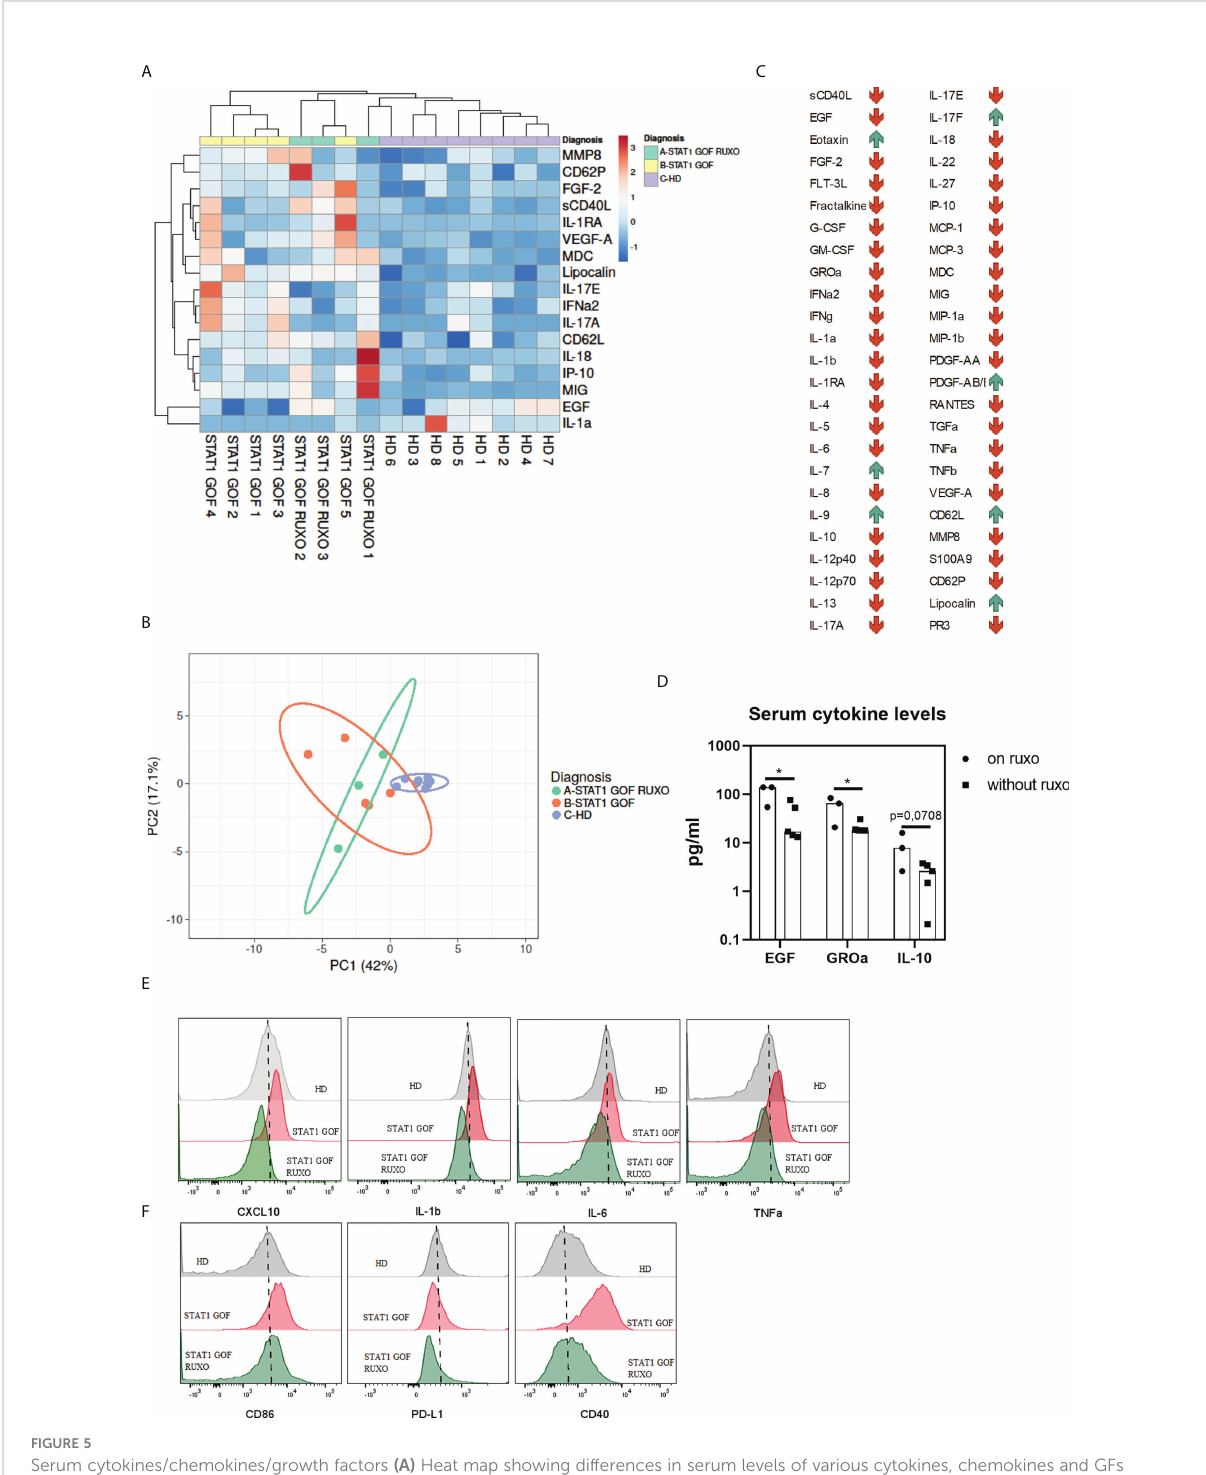
FIGURE 5 Serum cytokines/chemokines/growth factors (A) Heat map showing differences in serum levels of various cytokines, chemokines and GFs between STAT1 GOF patients (n = 5), ruxolitinib-treated STAT1 GOF patients (STAT1 GOF RUXO) (n = 3) and HDs (n = 7) detected by LUMINEX (B) Principal component analysis showing differences in serum levels of various cytokines, chemokines and GFs between STAT1 GOF patients (n=5), ruxolitinib-treated STAT1 GOF patients (STAT1 GOF RUXO) (n = 3) and HDs (n = 7) (C) Dynamics of analytes in a patient before and on ruxolitinib treatment (D) Differences in serum cytokine levels between ruxolitinib treated STAT1 GOF patients (n = 3) and untreated patients (n = 5) (E) Comparison of basal cytokine production by monocytes in HD, STAT1 GOF patient and the ruxolitinib-treated patient (F) Monocyte ’ s phenotype in HD, STAT1 GOF patient and the ruxolitinib-treated patient detected by fl ow cytometry HD - healthy donors; GF - growth factor. Values are standardized and expressed as median values. Statistical analyses were performed using paired t-tests. Values of p<0.05 (*), were considered statistically signi fi